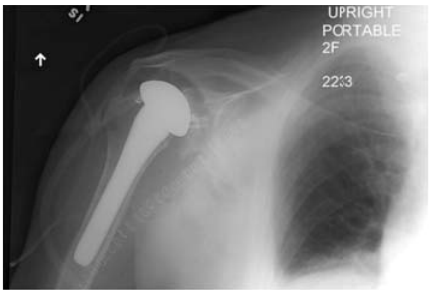
Figure 2: Postoperative X-ray, day of primary